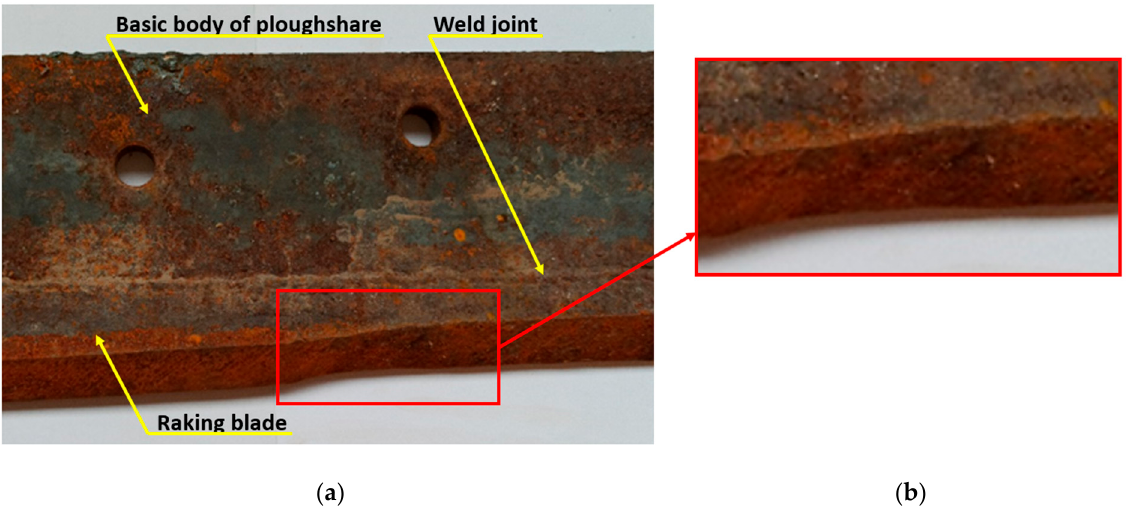
Figure 3. Part of the discarded ploughshare: ( a )—main parts of the ploughshare; and ( b )—detail of a raking blade).